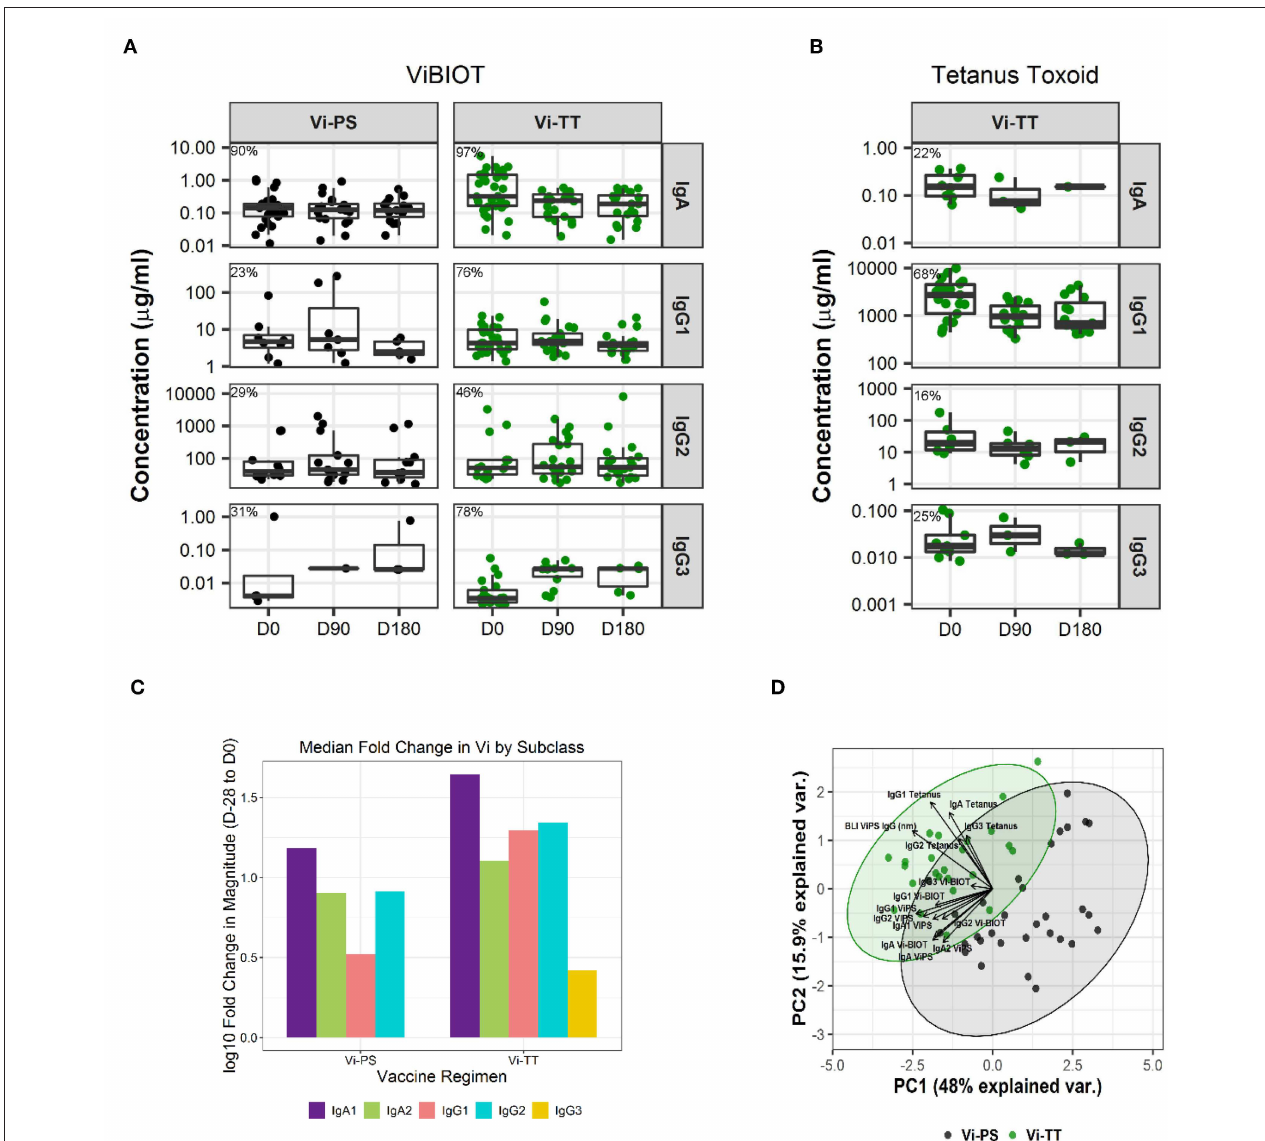
FIGURE 1 | IgA dominates the vaccine-elicited antibody response to Vi polysaccharide. Concentration of antigen-specific, vaccine-induced IgA, IgG1, IgG2, and IgG3 to ViBIOT (A) and tetanus toxoid (B) by vaccine group, Vi-PS in black and Vi-TT in green, of positive vaccine responders only. Percent positive responders indicated post-vaccination at D0. Vi-PS vaccinees exhibited no vaccine-induced tetanus toxoid response. Data points are representative of n = 2 independent experiments (each with n = 2 technical replicates). Fold-change in magnitude of the response to Vi from Baseline to Day of Challenge across subclasses by vaccine group (C) . A principal components analysis with all tetanus and Vi responses included (D) with a scatter plot of the first (PC1) and second (PC2) principal components is shown. Each measurement from a Vi-PS ( n = 35 participants) or a Vi-TT ( n = 37 participants) vaccinee is represented by a black or green dot, respectively. Ellipses represent 95% confidence